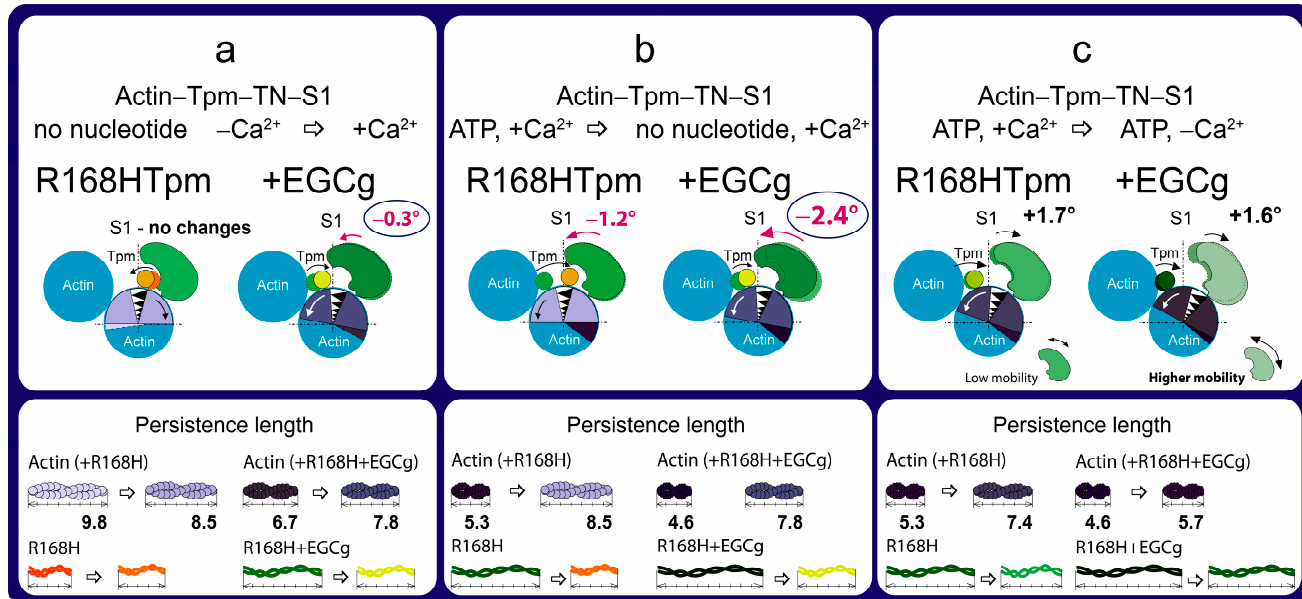
Figure 8. The scheme explains the effect of the troponin inhibitor EGCg on the spatial rearrangement of myosin head, the position of the R168H-mutant tropomyosin (Tpm), the angular orientation of actin monomer, and the persistence lengths of the Tpm strands and actin filaments compared to R168HTpm in the absence of EGCg. Three different transitions are shown, influenced by ( a ) an increase in Ca 2+ concentration in the absence of nucleotides, ( b ) a weak-to-strong transition, and ( c ) a decrease in Ca 2+ concentration in the presence of ATP. The designations are as in Figure 3.